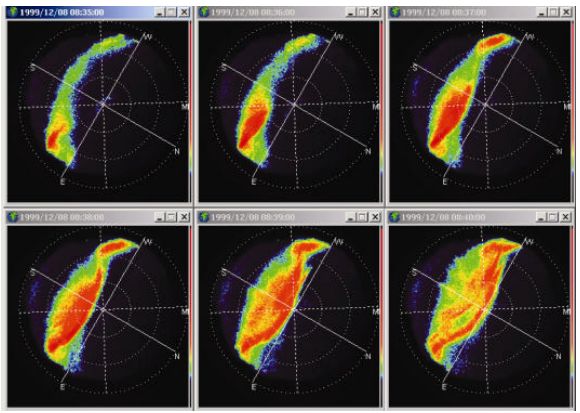
Figure 8 Fig. 8. ASC images at 630.0nm from Ny ˚Alesund, representing the times 08:35:00, 08:36:00, 08:37:00, 08:38:00, 08:39:00, and